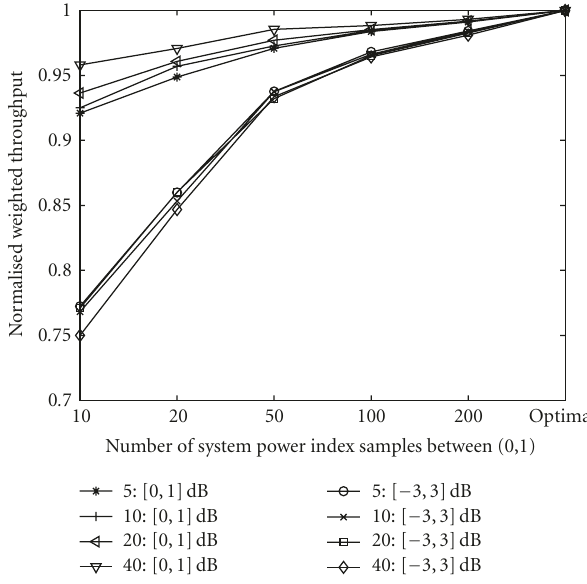
Figure 1: The impact of number of samples on the weighted throughput